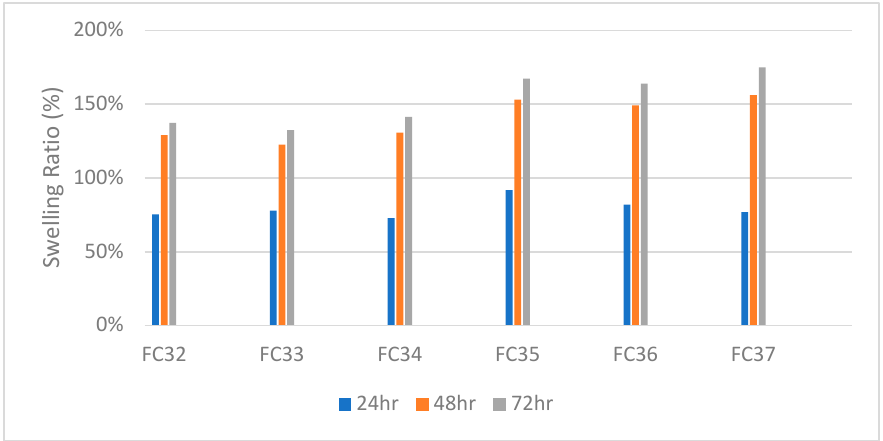
Figure 9. Swelling ratio (%) of formulations FC32–FC37.